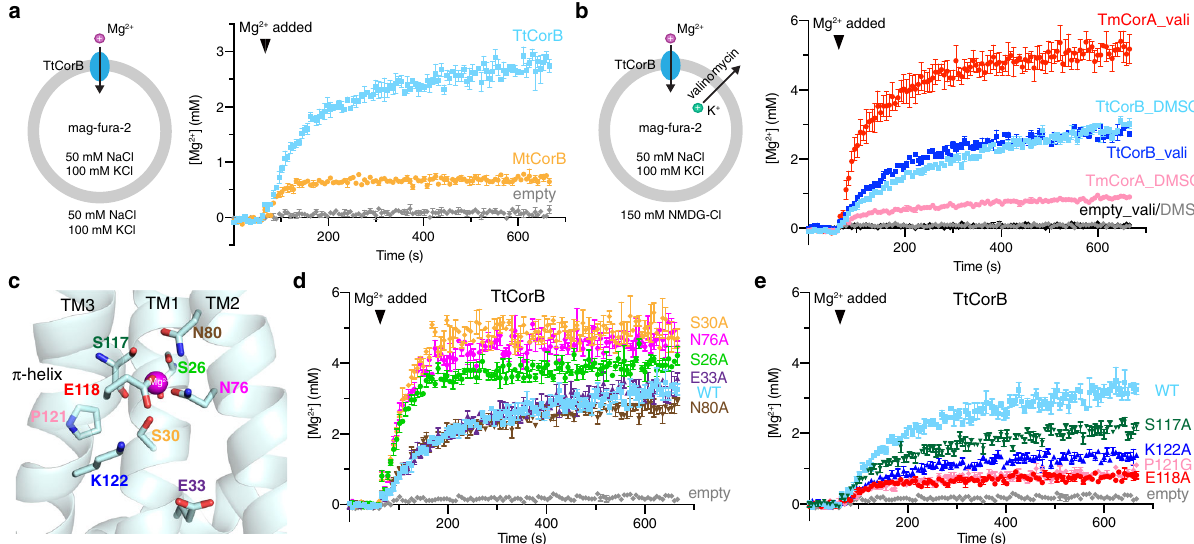
Fig. 6 Liposome-based assay shows direct Mg 2 + transport by CorB proteins. a Liposomal assay showing direct transport of Mg 2 + by MtCorB and TtCorB. Proteoliposomes (protein/lipid ratio of 1:30) or empty liposomes containing mag-fura-2 were equilibrated for 1 min before the addition of 5 mM MgCl 2 to initiate Mg 2 + uptake ( arrowhead ). The data points represent mean ± SEM ( n = 3 independent measurements). b An inward negative membrane potential generated by valinomycin leads to enhanced Mg 2 + transport by TmCorA (protein/lipid ratio of 1:270) but not TtCorB (protein/lipid ratio of 1:30), suggesting electroneutral transport of Mg 2 + by TtCorB. The data points represent mean ± SEM ( n = 3 independent measurements). c Homology model of TtCorB showing locations of conserved residues in the negatively charged cavity and Mg 2 + binding site. d , e Liposomal Mg 2 + transport assays of TtCorB mutants under the same experimental conditions as panel ( a ). Mutations in the Mg 2 + -binding site increased transport activity while mutations near the π -helical turn reduced transport. The data points represent mean ± SEM ( n = 3 independent